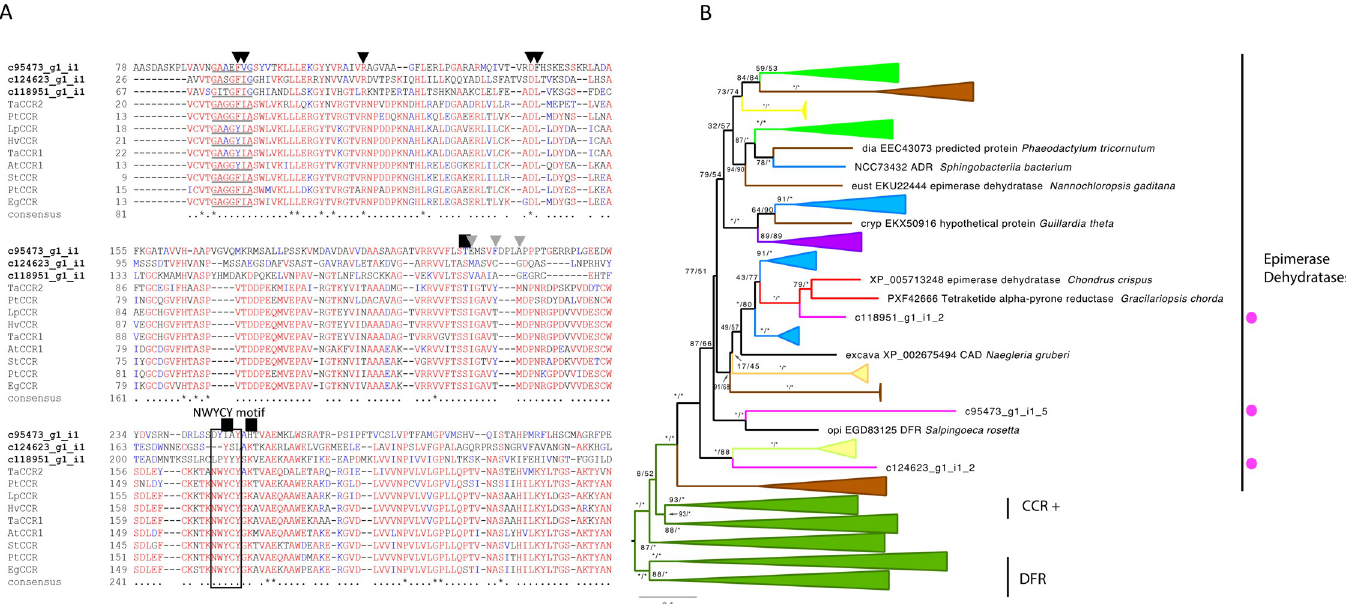
Fig 3. CCR candidates from C . tuberculosum in relation to plants and other taxa. (A) Partial alignment C . tuberculosum candidates (bolded) and land plant CCR sequences. Catalytic residues are labelled with NWYCY [52] and additional residues are indicated above with a black box. NADPH binding pocket residues are indicated with black triangles [53] and the GXXGXX[A/G] motif is underlined [54]. Hydroxycinnamonyl binding pocket residues are indicated with a gray triangle [53]. (B) CCR maximum likelihood gene tree showing relationships between C . tuberculosum (magenta dots) and other taxa (Embryophyta–dark green, Chlorophyta–light green, Rhodophyta–red, Animalia and Opisthokonta–purple, Bacteria and Cyanobacteria–blue, Oomycota, Mycetozoa and Fungi–yellow, Ochrophyta–brown). Functionally demonstrated plant CCRs are labelled (+). Additional functional groups are labelled. Ultrafast bootstrap values > 95 are marked by � . Model = LG+G4. Sites with � 80% occupancy were removed. Accession numbers can be found in S1